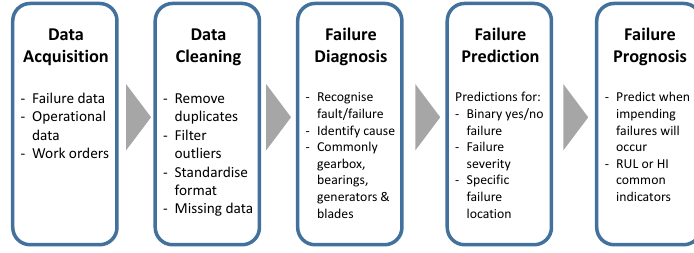
Figure 6. Process from failure data acquisition to failure